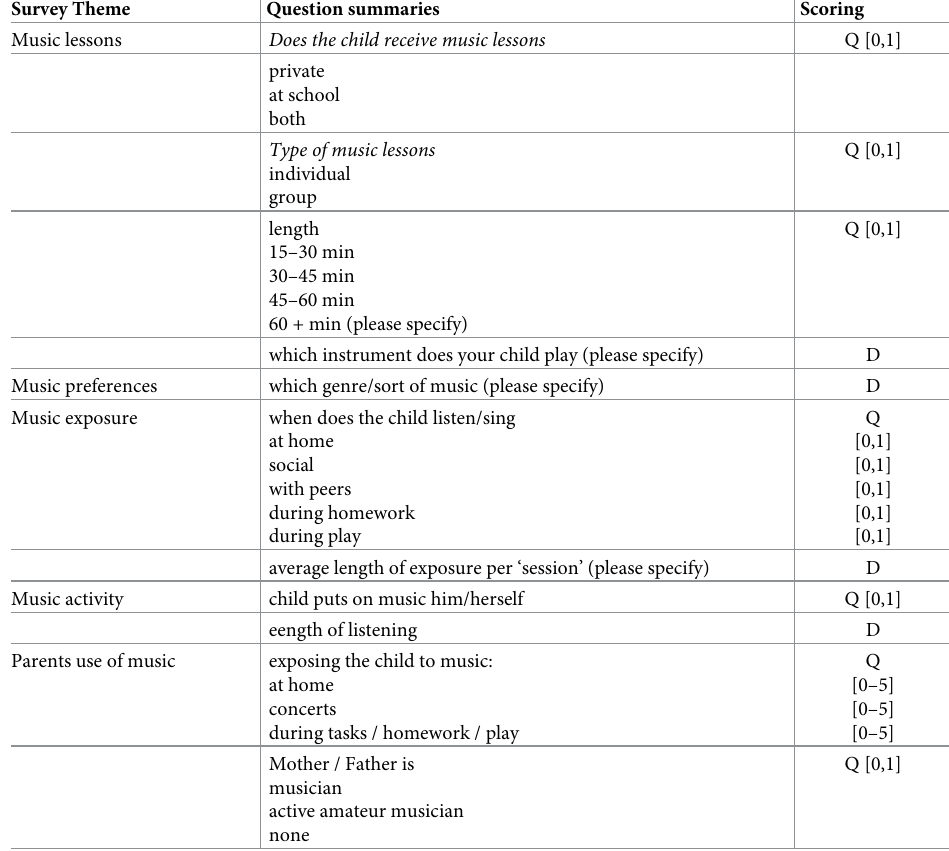
Table 2. MEE, excerpt from the self-created intake